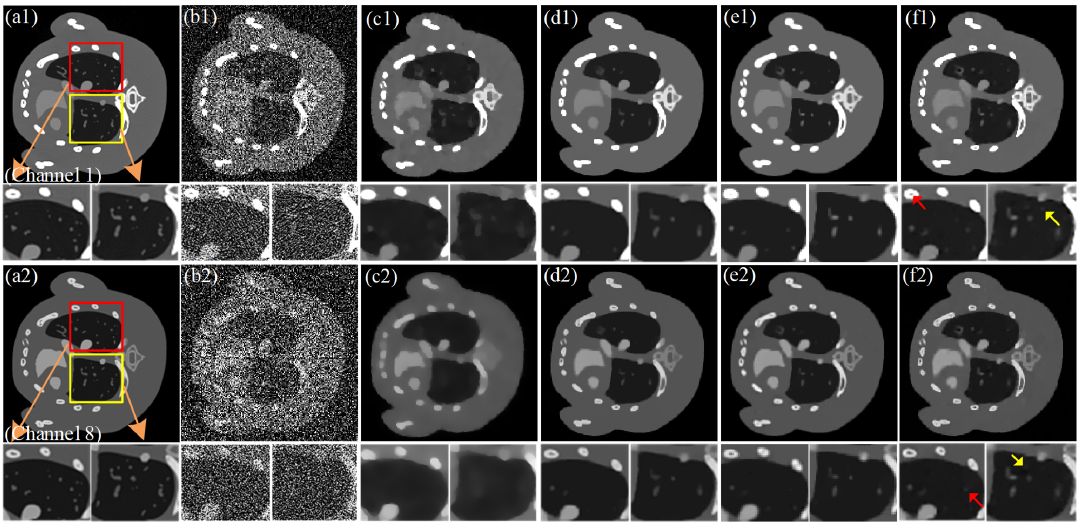
Figure 2. Reconstructed images from 160 projections using different methods. The first two rows are the first channel and ROIs, the last two rows are the eighth channel and ROIs. From left to right, the columns are Ground Truth ( a ), FBP ( b ), TV ( c ), TVLR ( d ), TDL ( e ), and our algorithm ( f ). The display windows are [0, 0.25] cm − 1 and [0, 0.08] cm − 1 , respectively.